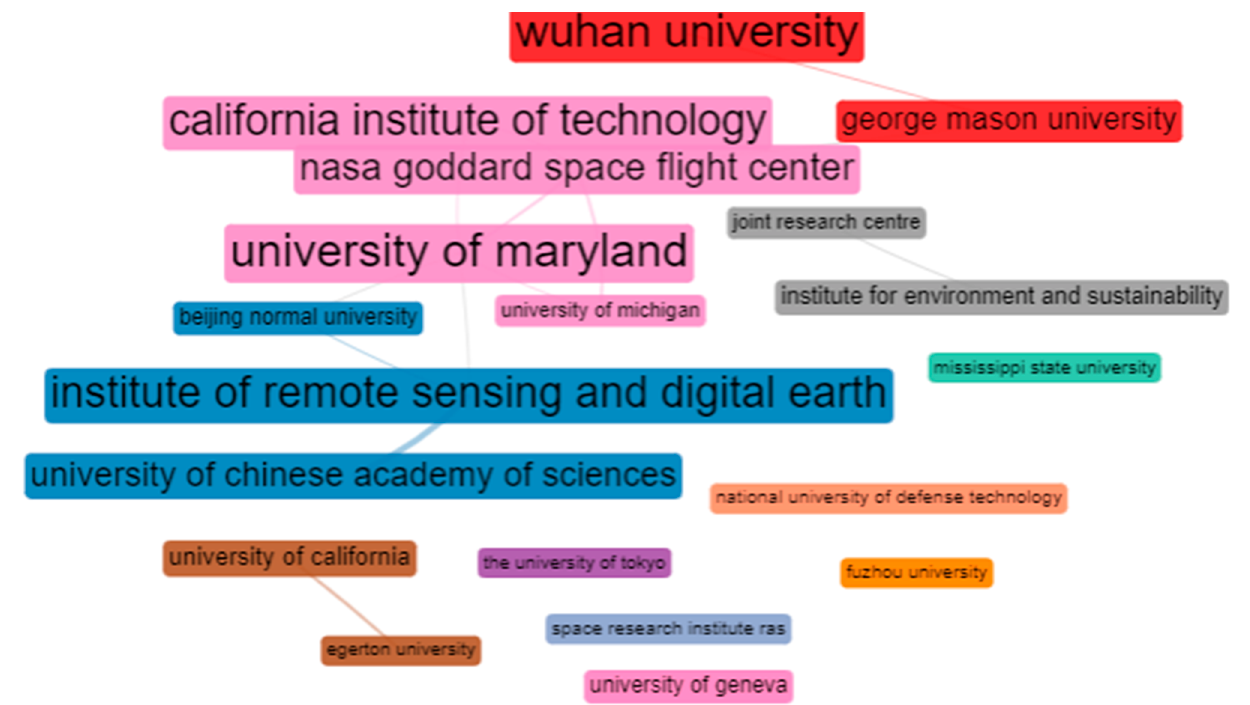
Figure 4. Top 20 Collaboration between institutions network on EOS and PM studies.